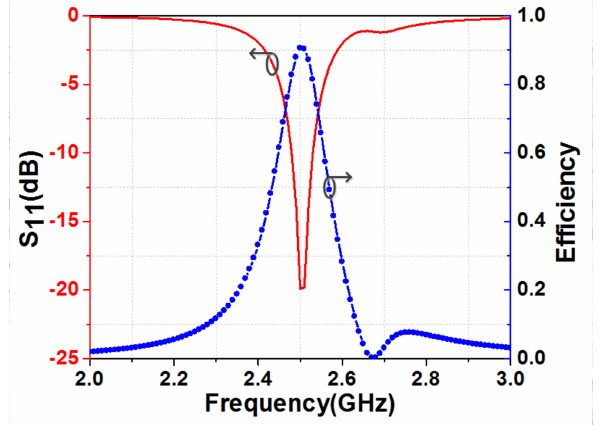
Figure 4. Reflection coefficient S 11 and power harvesting efficiency using square-ring MS